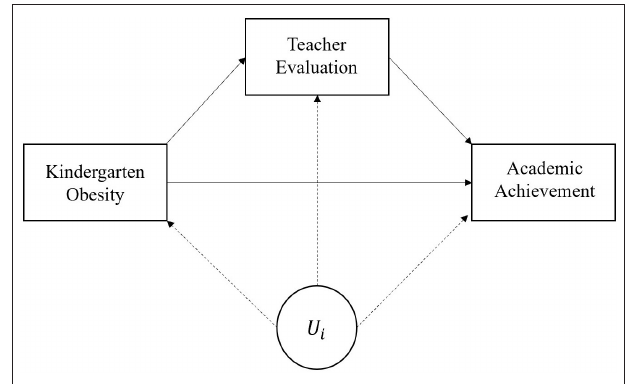
FIGURE 1 | Baseline mediation model and unobserved